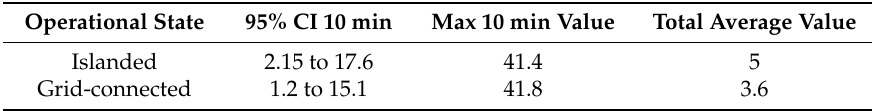
Figure 12. CDF for the 10 min RMS neutral current during islanded and grid-connected operation.